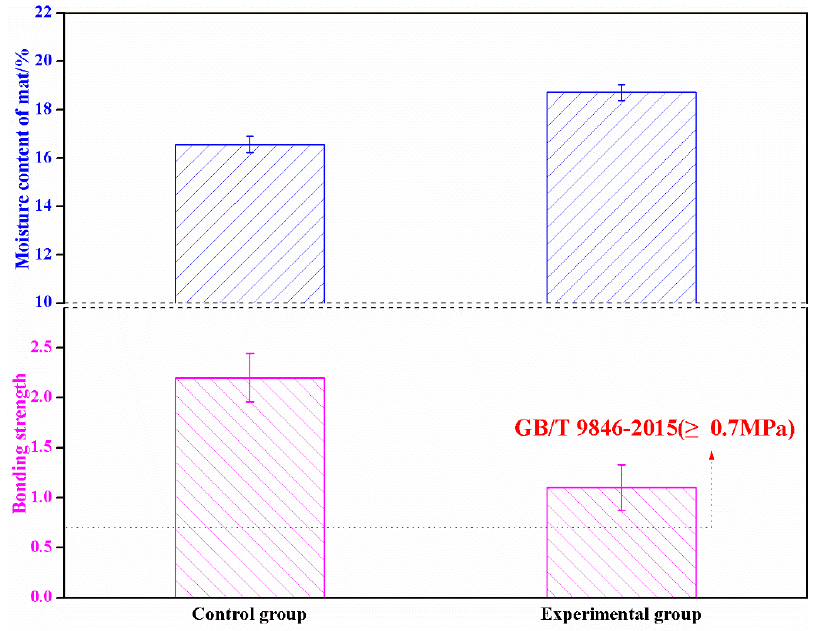
Figure 5. Bonding performance of